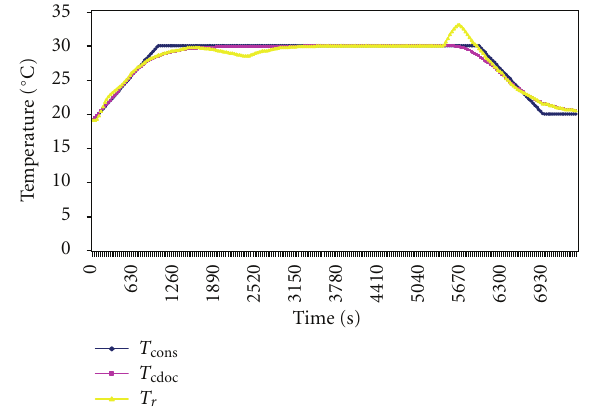
Figure 8: Evolution of temperature ( T cons ), the adjusted set-point ( T cdoc ), and reaction mixture ( T r ), K = 1, K r = 0.5.